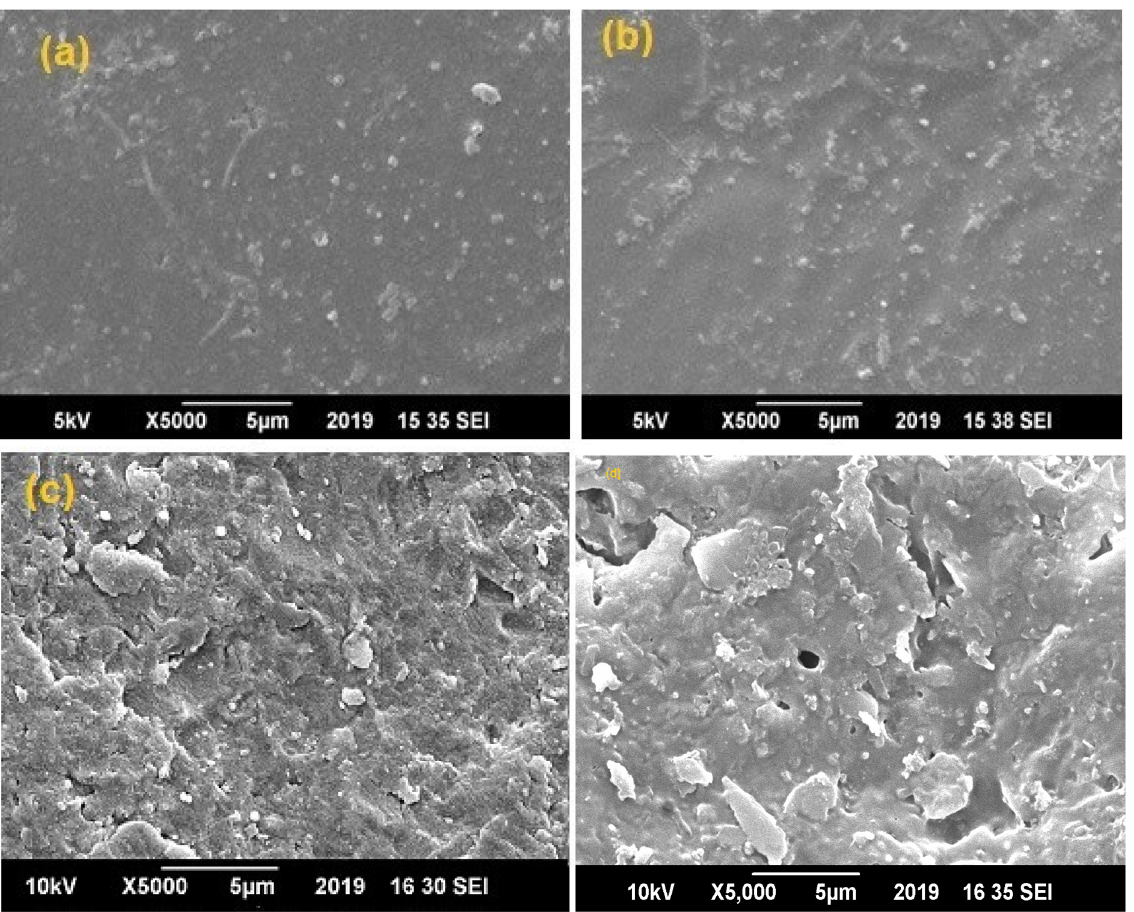
Figure 1. SEM images of ( a ) Sample F-1 (80% PLA and 20% EVA), ( b ) Sample F-2 (70% PLA and 30% EVA), ( c ) F-3(50% PLA and 50% EVA) and ( d ) Sample F-4 (30% PLA and 70%